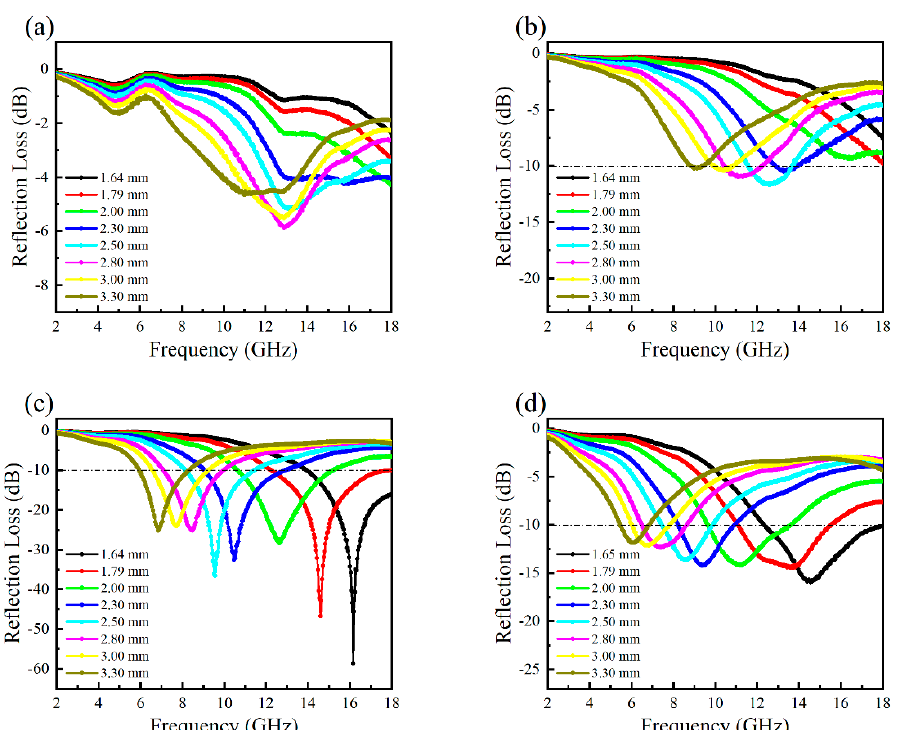
Figure 7. The reflection loss curves of all composites. ( a ) The reflection loss curve of CNC; ( b ) The reflection loss curve of CNCG-1; ( c ) The reflection loss curve of CNCG-2; ( d ) The reflection loss curve of CNCG-3.